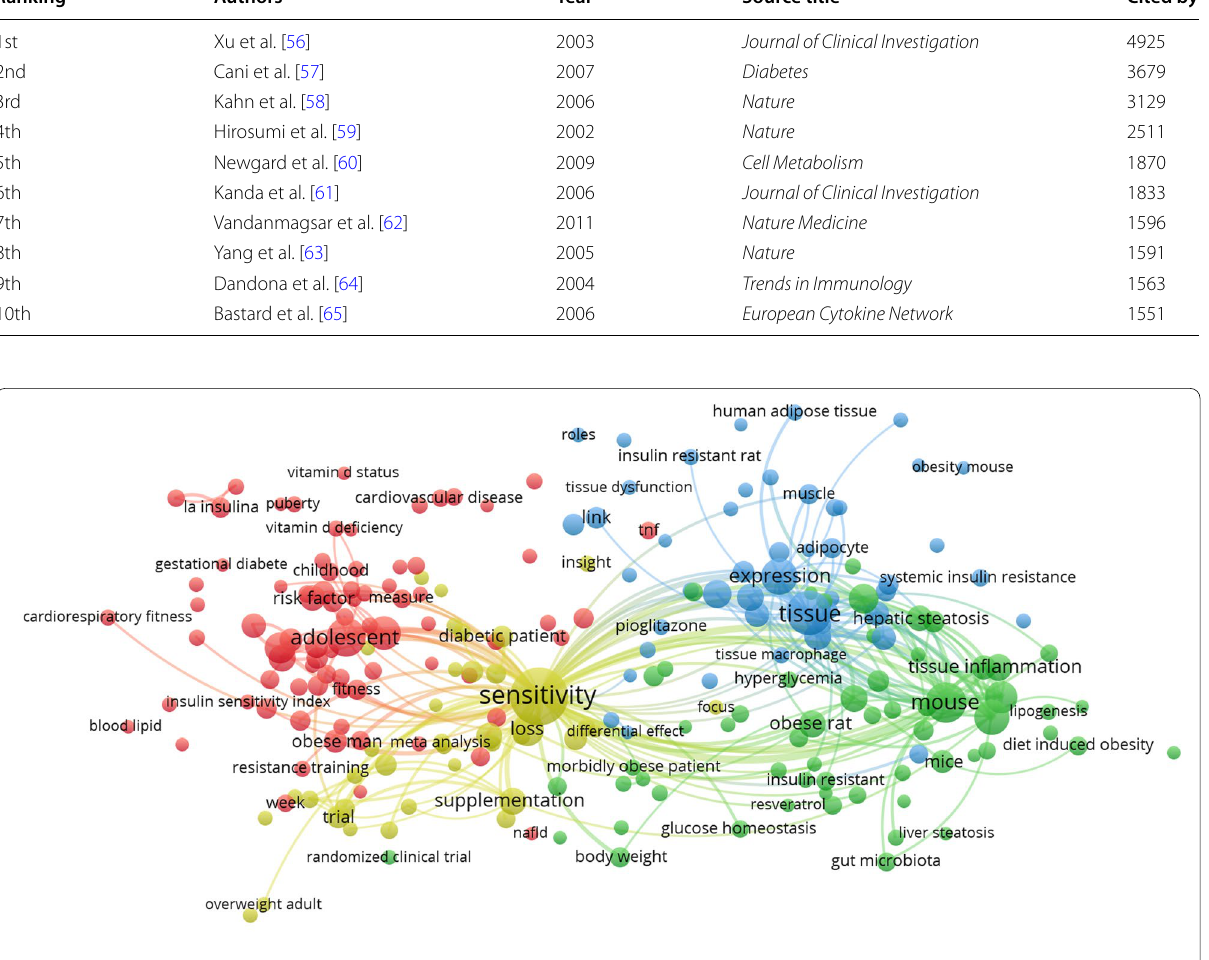
225). Different clusters =